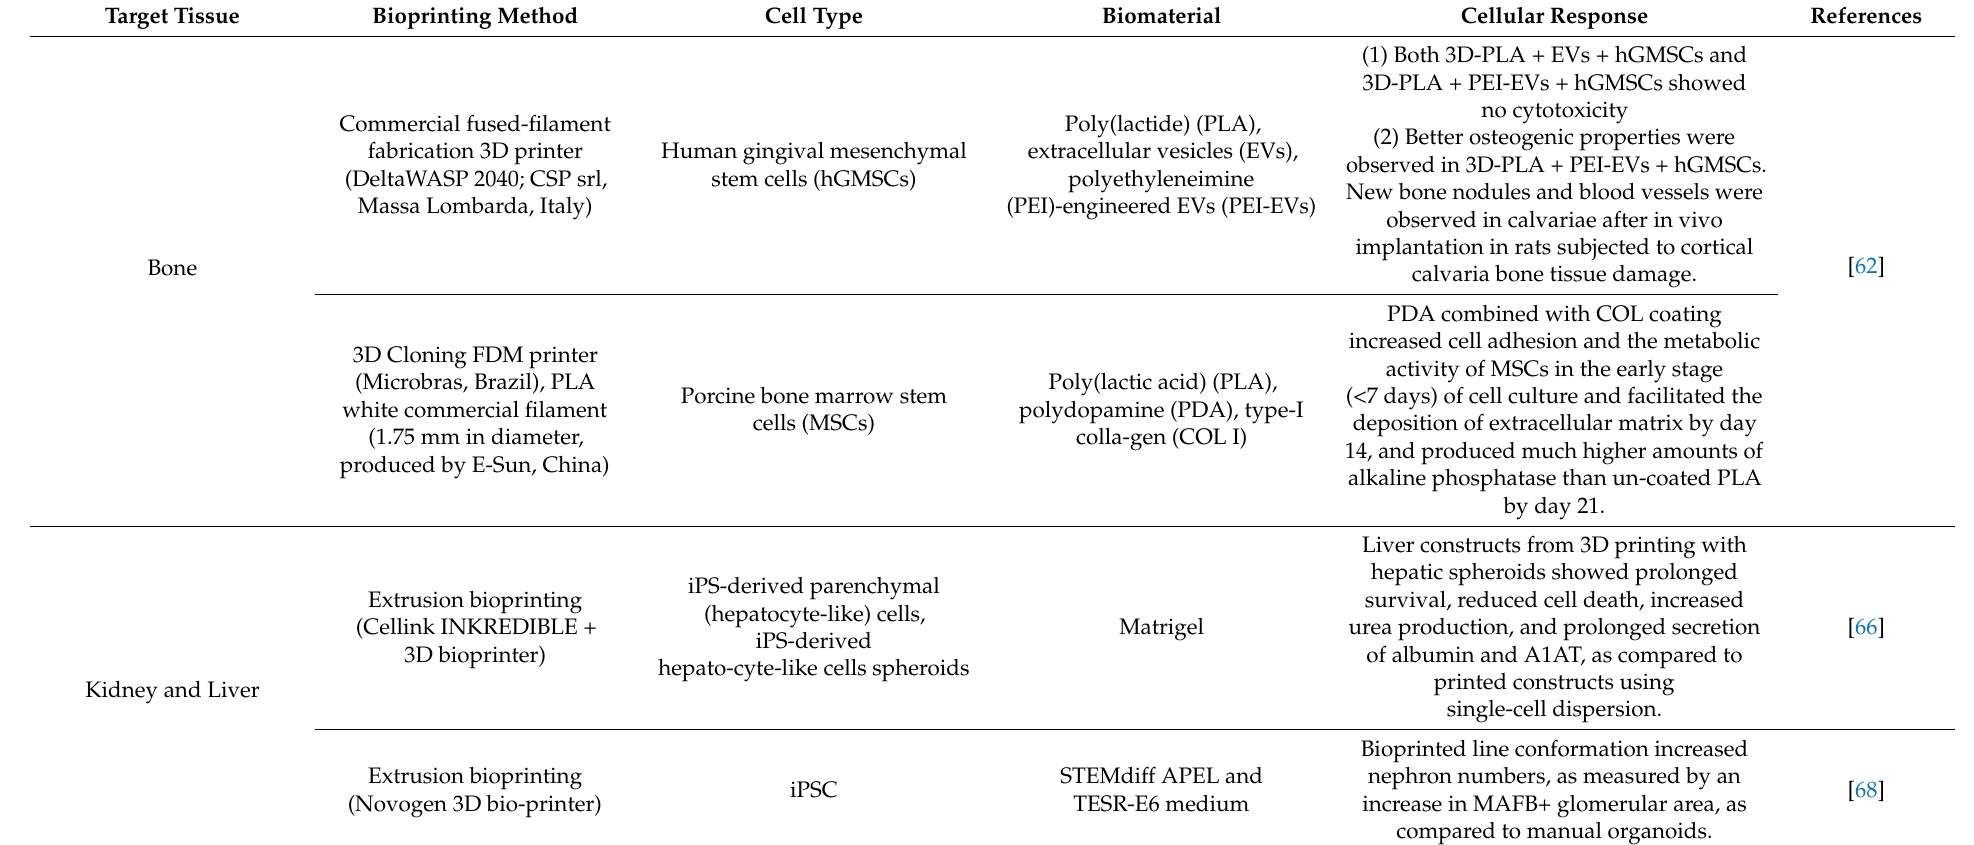
Table 3. Summary of selected major discoveries in bioprinting